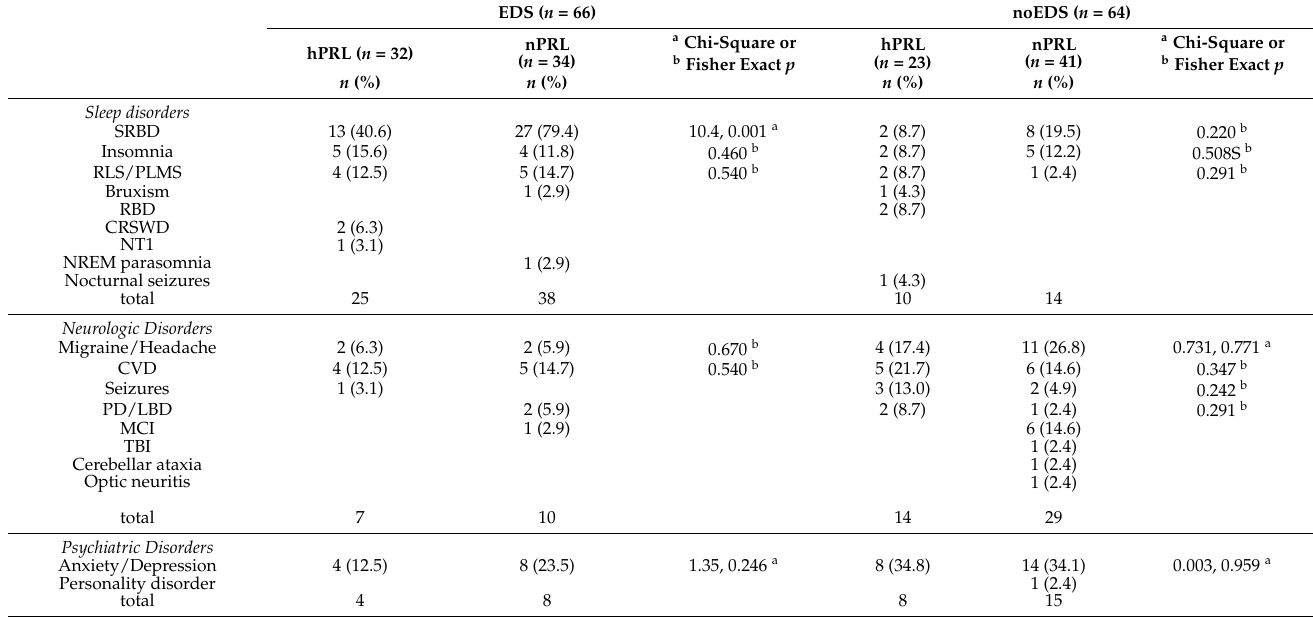
Table 1. Sleep, neurologic, and psychiatric disorders found in the whole group of participants, subdivided by level of prolactin (PRL) and complaint of excessive daytime sleepiness (EDS).